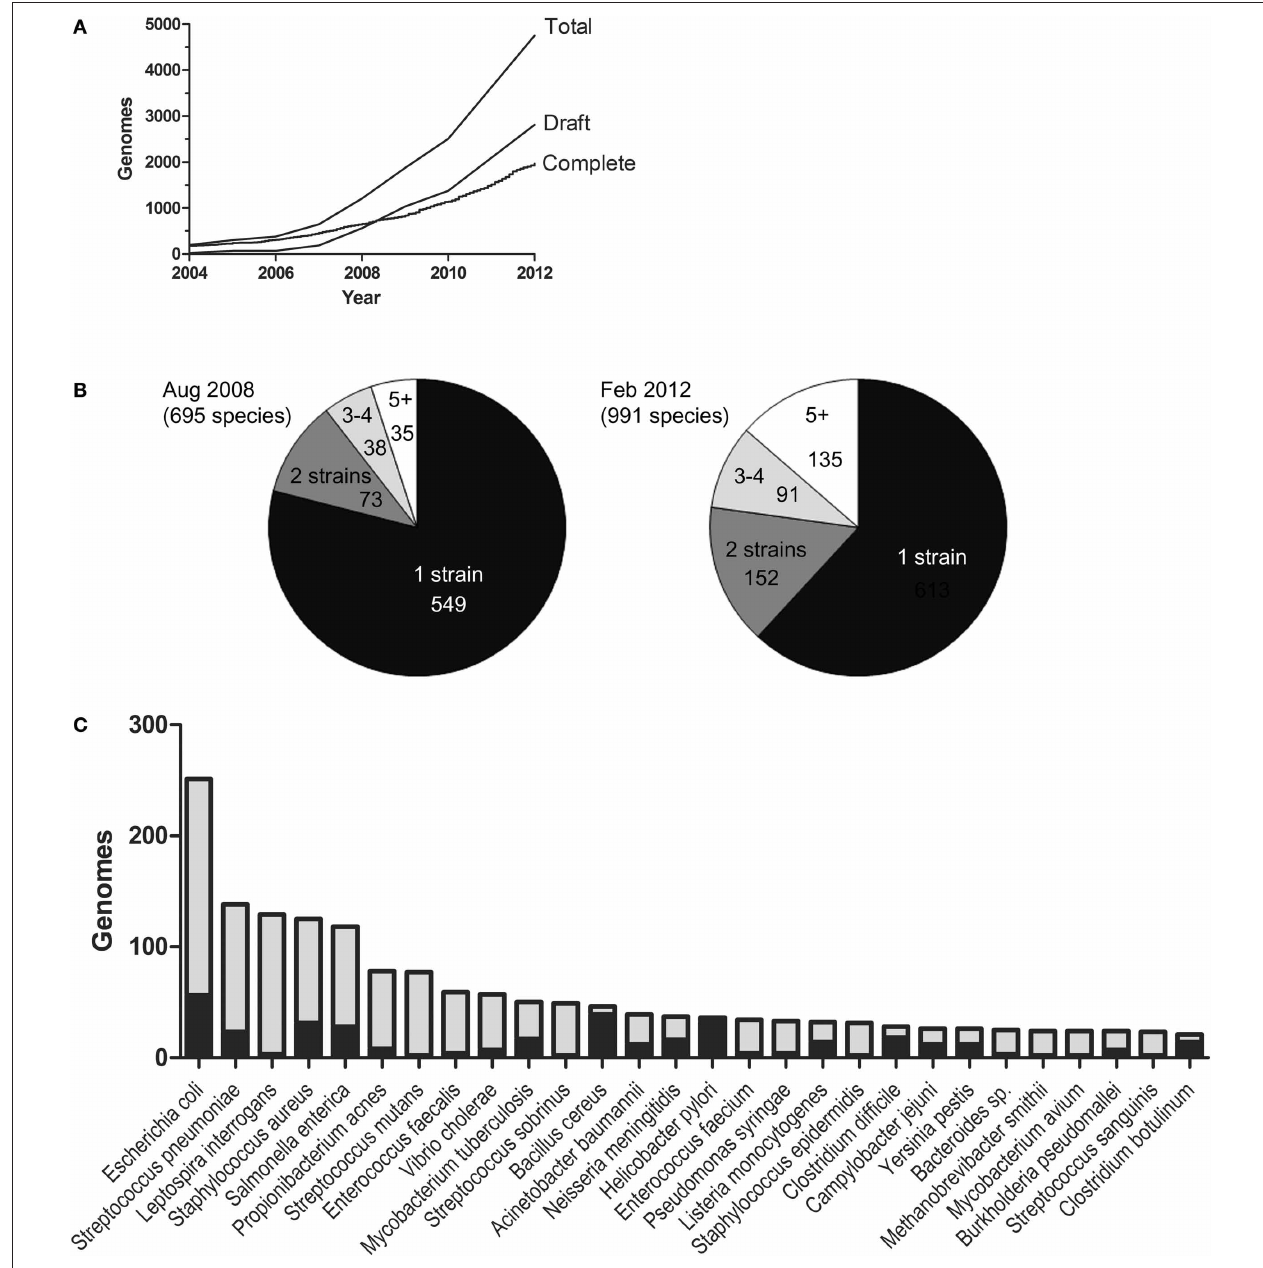
FIGURE 1 | The genome database. The figure is based on the NCBI GenomeReport dated 21 Feb, 2012 and only includes genomes projects where completed sequences or draft assemblies were available for download. (A) The growth of the databases for draft and complete bacterial